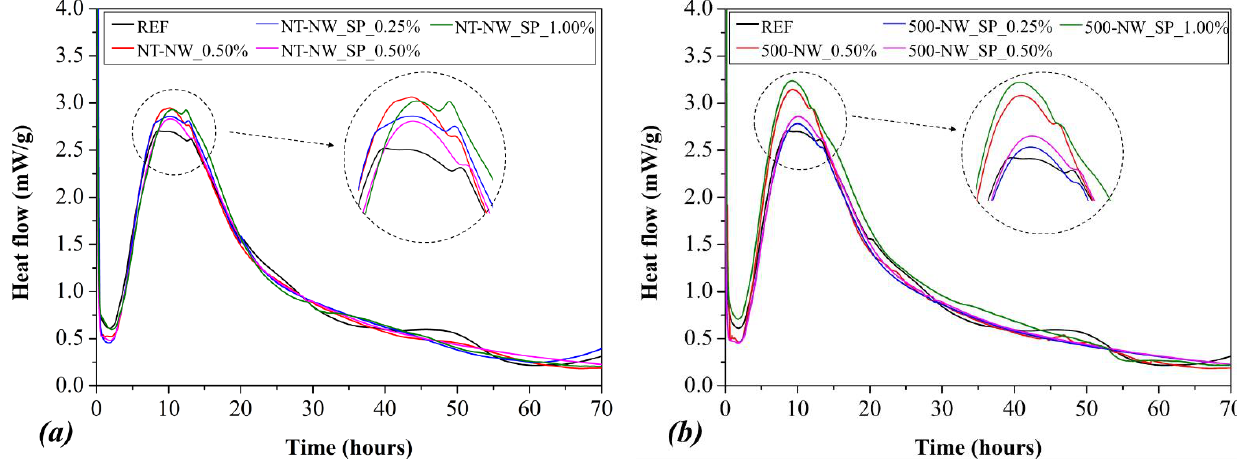
Figure 5. Heat flow of ( a ) NT-NW and ( b ) 500-NW pastes during the first 70 h of hydration. The insets highlight the main heat flow peak.